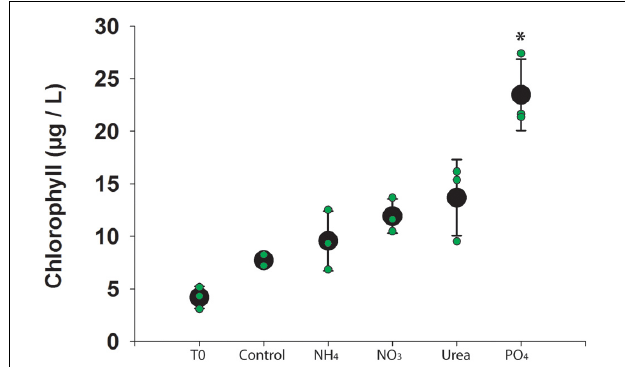
FIGURE 1 | Chlorophyll a concentration across experimental manipulations. Individual bottles are denoted in green and the average is denoted in black. Error bars represent standard deviation and star ( ∗ ) indicates significant difference from control ( p < 0.05).